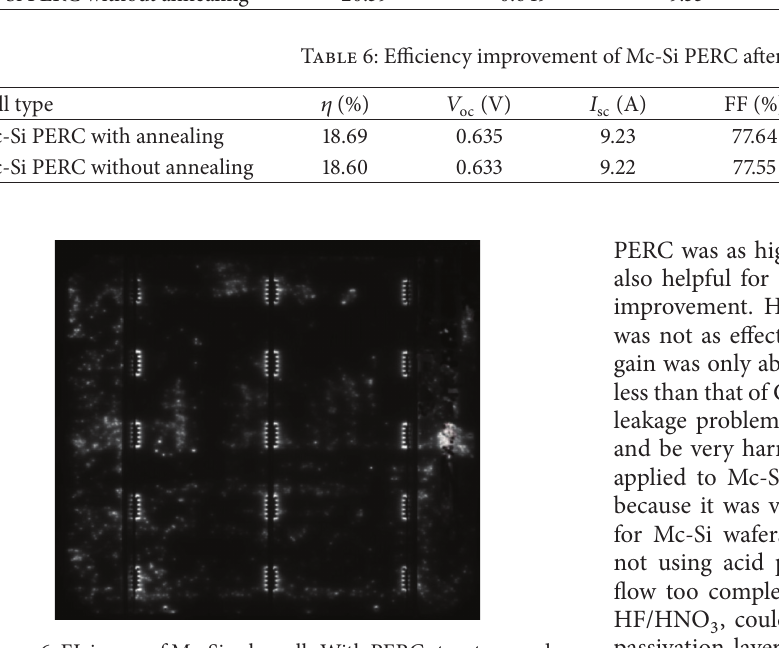
Figure 6: EL image of Mc-Si solar cells With PERC structure under reverse